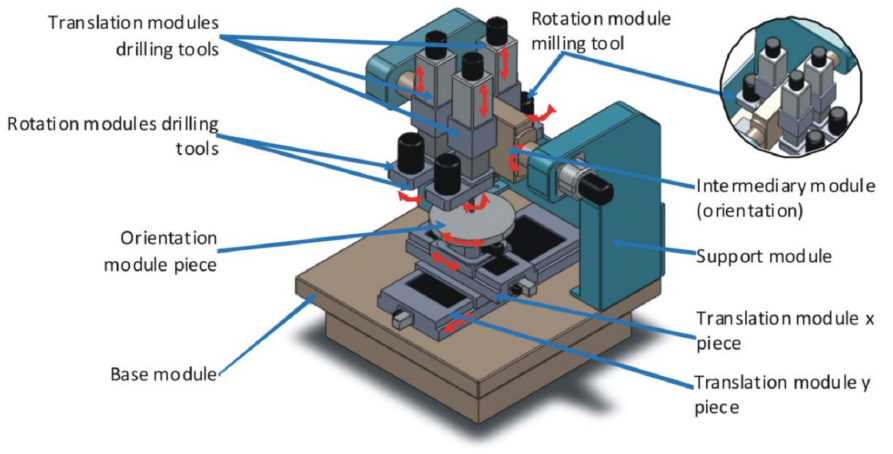
Figure 3. Particle 1 at iteration 1: variant